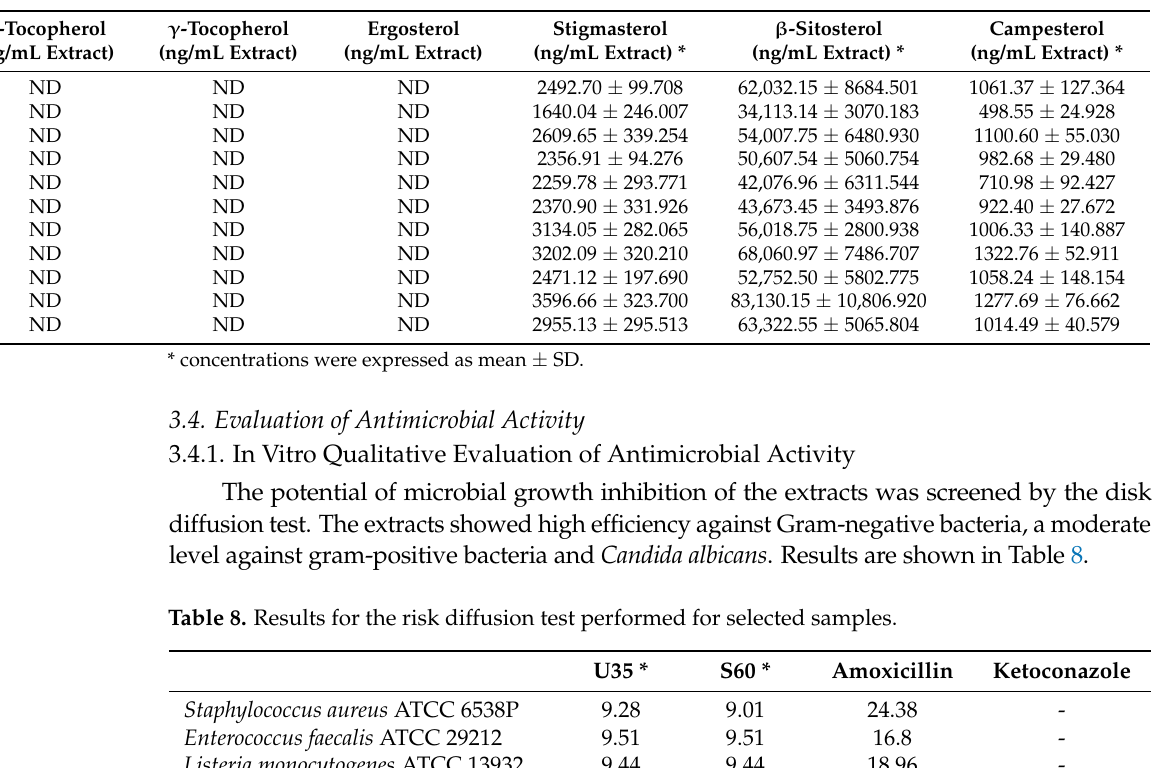
Table 7. Sterolic compounds in the selected extracts.